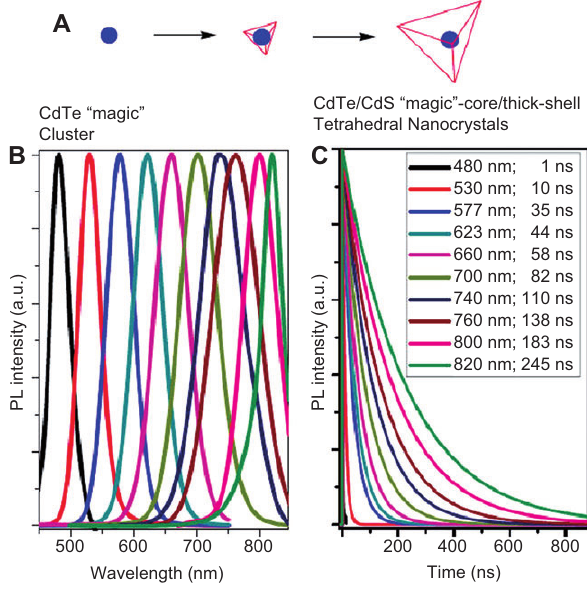
Figure 1 (A) Schematic diagram illustrating the formation of the CdTe/CdS magic-core/thick-shell tetrahedral NCs. (B) Room- temperature PL emission profiles of a series of NC samples obtained by varying the CdS shell growth to overcoat the magic-sized CdTe core with thicker shells. (C) Room-temperature PL decay kinetics monitored at the maximum emission wavelengths of the samples in (B). The calculated excited state lifetimes are listed. (Reproduced with permission from ACS Publication.)